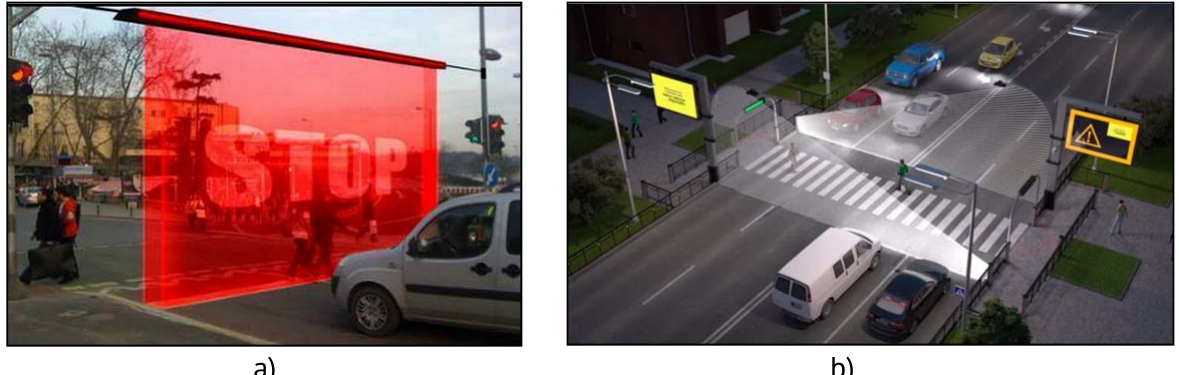
Figure 7. Pedestrian crossing with laser design